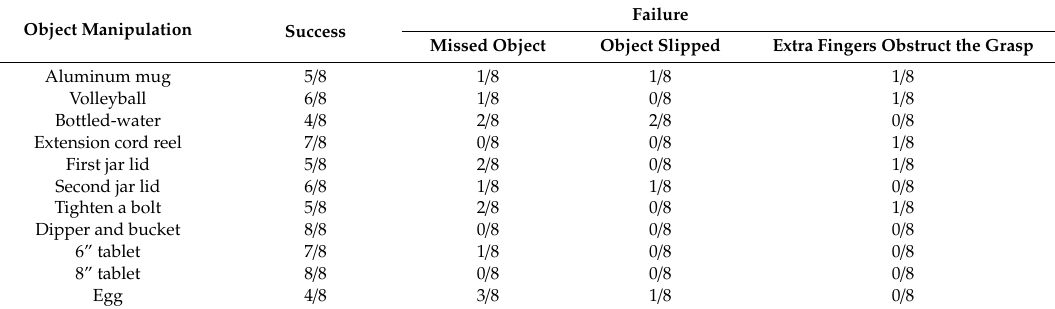
Table 6. Experimental results of bimanual task